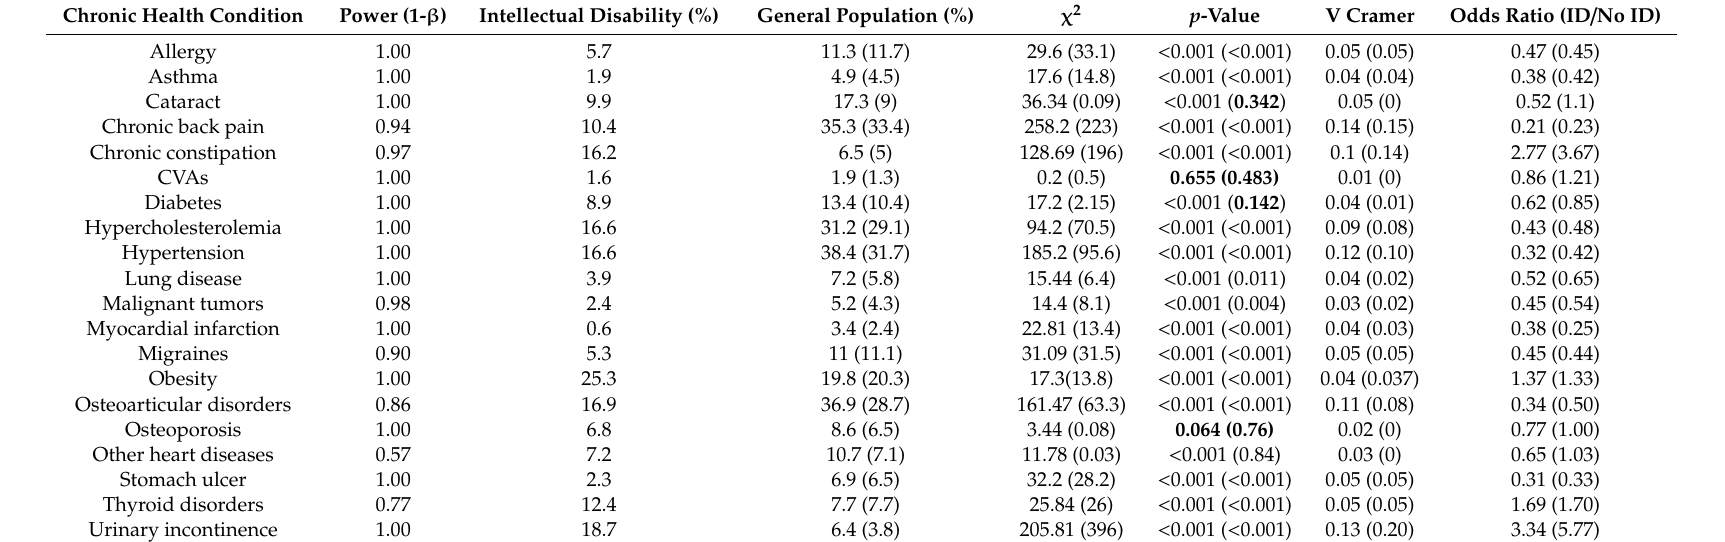
Table 4. Prevalence of chronic health conditions in people over 44 years with intellectual disability (ID) and without